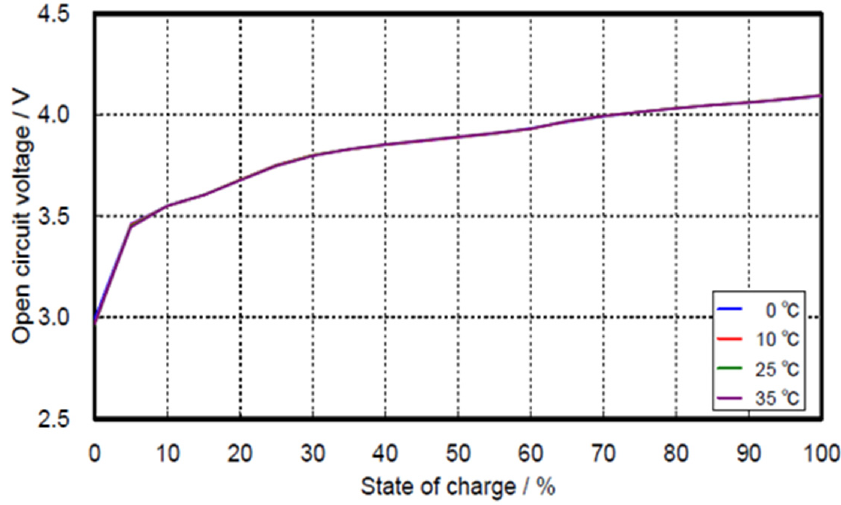
Figure 2. Manufacturer’s data of the open circuit voltage versus SOC [31].